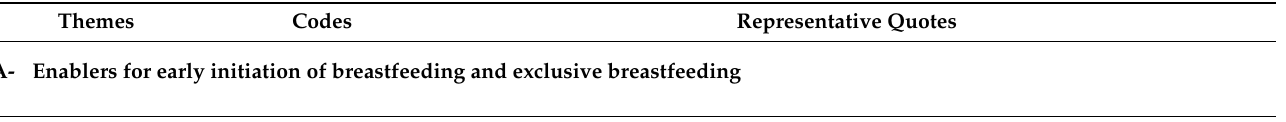
Table 5. Enablers and barriers for the initiation of breastfeeding and exclusive breastfeeding among Syrian refugee mothers of children under five years in vulnerable areas of Greater Beirut, Lebanon –qualitative analysis of focus group discussion (N =